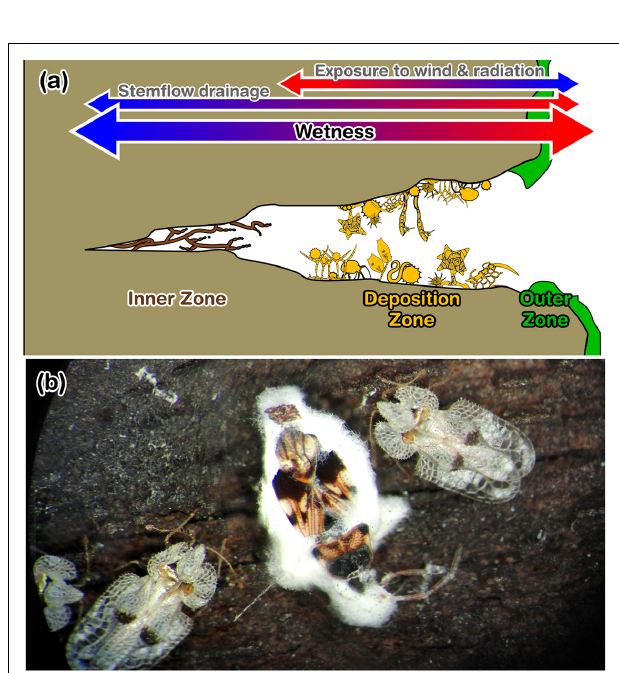
FIGURE 8 | (a) Zones of the bark microhabitat per Magyar (2008), their relative wetness (per stemflow and atmospheric exposure), and their observed microhabitat components. The outer zone consists of lichens, mossed and melanized fungal mycelia. Components of the deposition zone are diverse and abundant, like spores, pollen grains, dust, mites, nematodes and testate amoebae. The inner zone primarily hosted dematiaceous (or “black”) fungi colonies. (b) Photograph showing example fungal infection of overwintering insects by bark fungi: Beauveria sp. on Heteroptera sp. and Corythucha ciliata on a Platanus tree in Budapest, Hungary (credit: D.